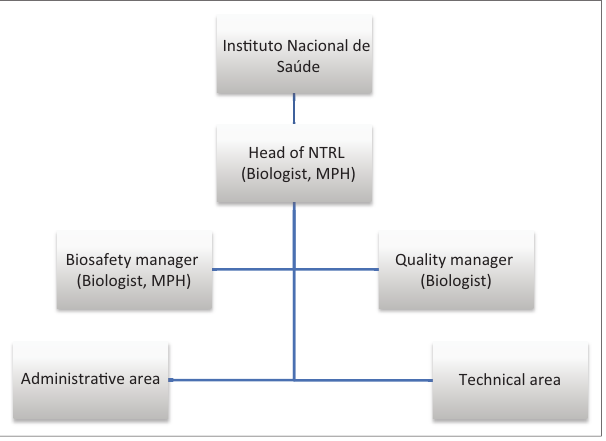
FIGURE 1: National Tuberculosis Reference Laboratory organizational structure,